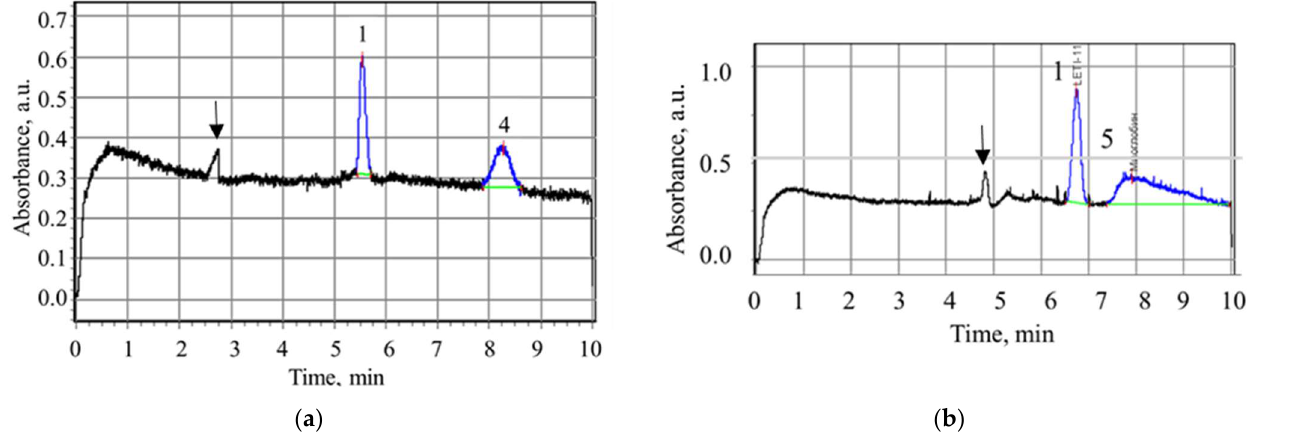
Figure 11. Electropherogram of the mixture of (1) LETI-11 (1.5 μM), 5.5 min and (4) homoMPO (2.2 μМ), 8.2 min, capillary pretreatment type A ( a ) and (1) LETI-11 (2.0 μM), 6.7 min and (5) MB (4.2 μM), 8 min, capillary pretreatment type B ( b ), рН = 7.2, 0.01 М tris-HCl buffer solution; the arrows show the systemic peak corresponding to the electroosmotic flow velocity.